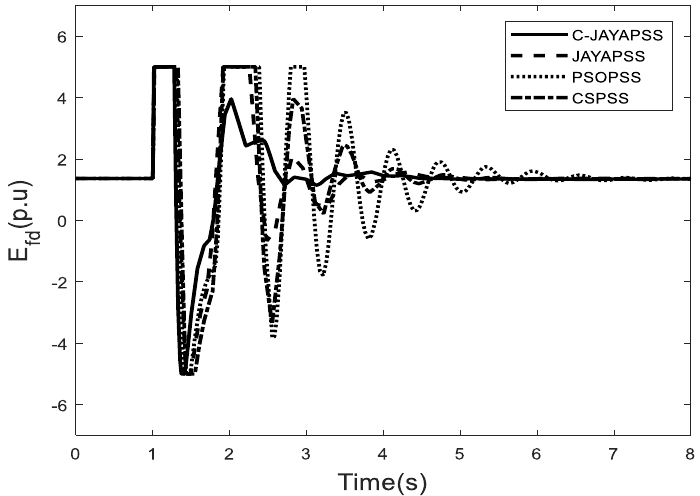
Figure 10. The field voltage for a six-cycle fault disturbance with case 1.